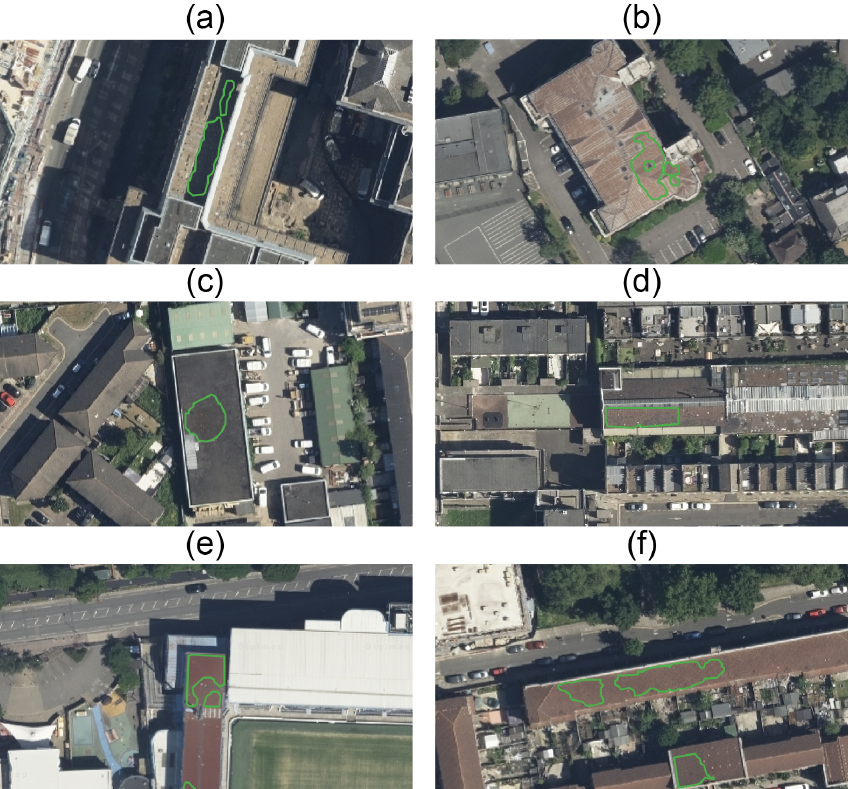
Figure 8. Examples of false positive classification in the 2021 imagery. The green outline shows the area identified as green roof by the model. Imagery © GetMapping Plc. Image location is shown in Fig. A3.